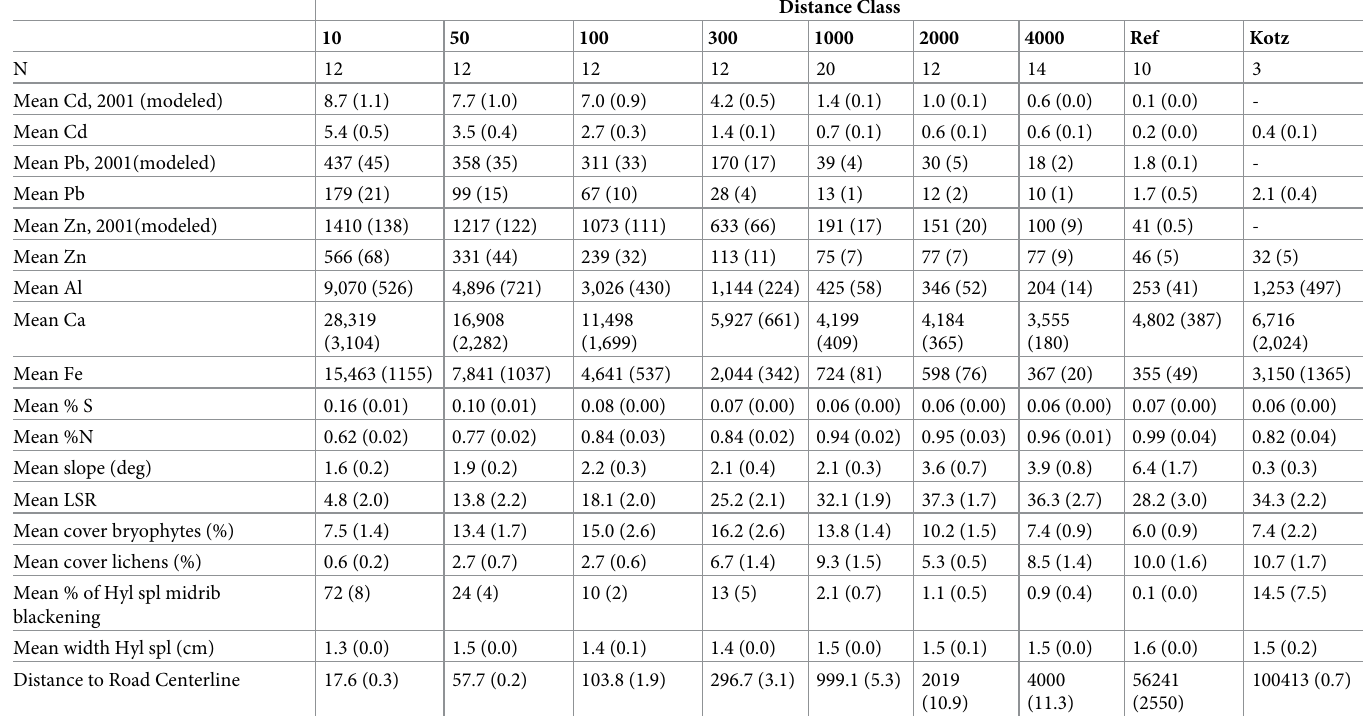
Table 1. Mean values of important co-variates at the full range of distance classes from the DMTS haul road in CAKR, with the standard error of the mean (pre- sented in parentheses). Mean elemental values are mg/kg in Hylocomium splendens tissue, dry weight, except % Total S and % Total N. Values are presented for the Refer- ence Sites and the Kotzebue road sites that were not included in subsequent analyses of vegetation community structure. The 2001 values for Cd, Pb and Zn are from Hasselbach et al.